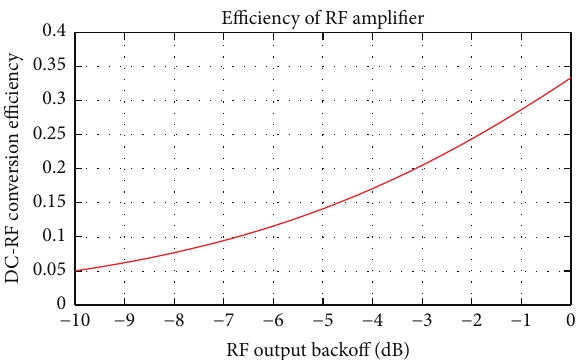
Figure 10: Power amplifier DC-RF conversion efficiency.